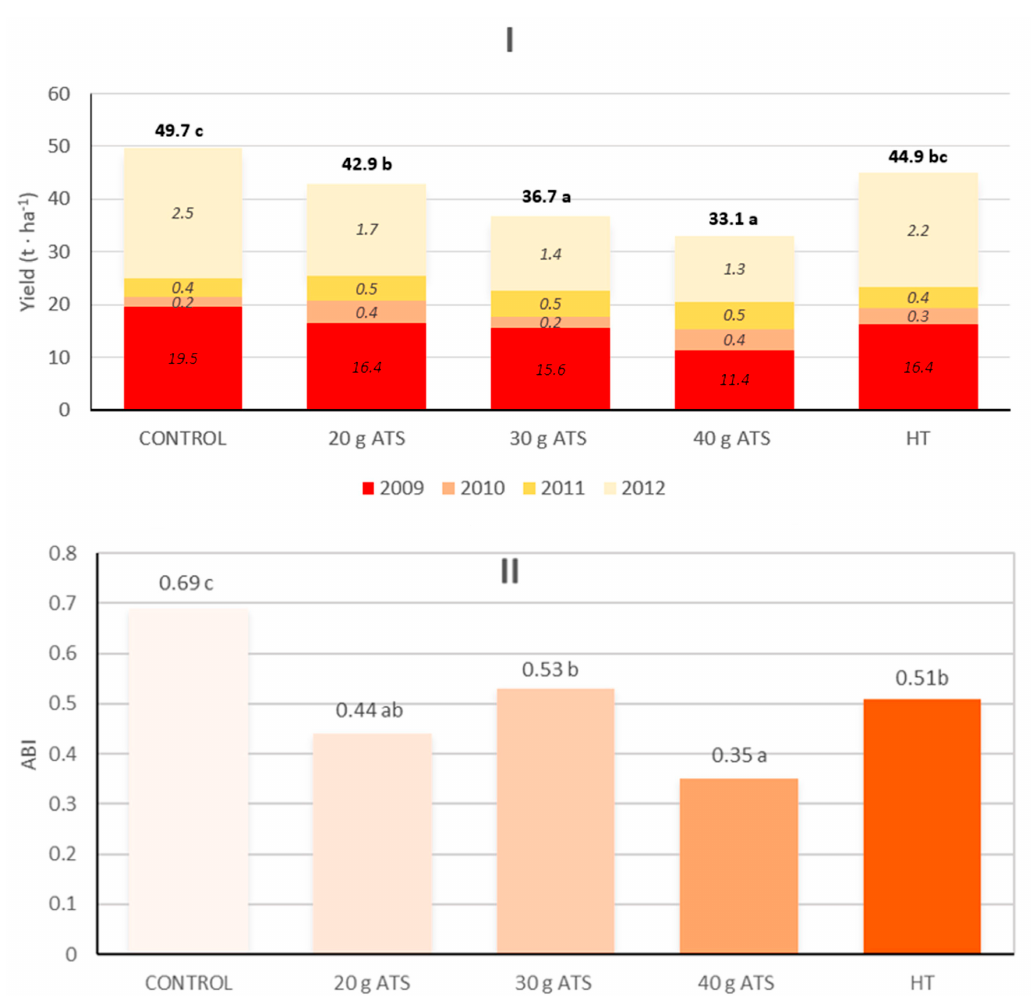
Figure 5. The e ff ect of thinning on cumulative yield of ‘Regina’ sweet cherry trees in 2009–2012 ( I ) and alternate bearing index—ABI ( II ) 1 One-way analyses of variance; data in bars marked with the same letter are not significantly di ff erent at α = 0.05 (Duncan’s